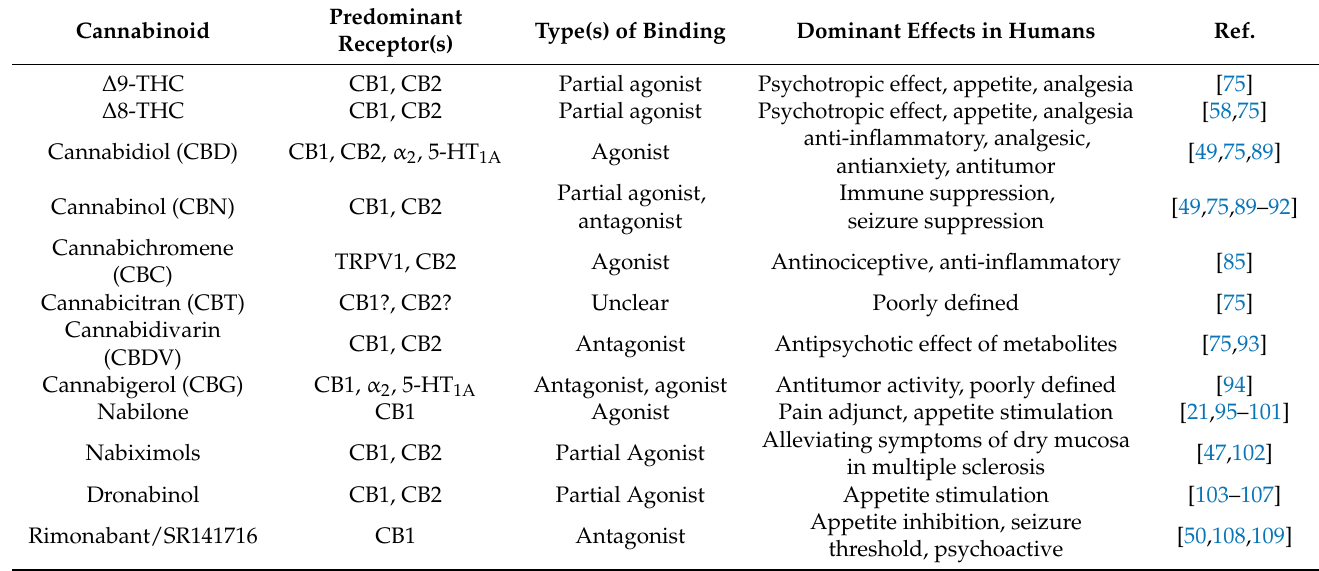
Table 1. Naturally and artificially synthesized cannabinoids and their main biological effects. Addi- tionally included are the specific cannabinoid receptor and type of receptor which are